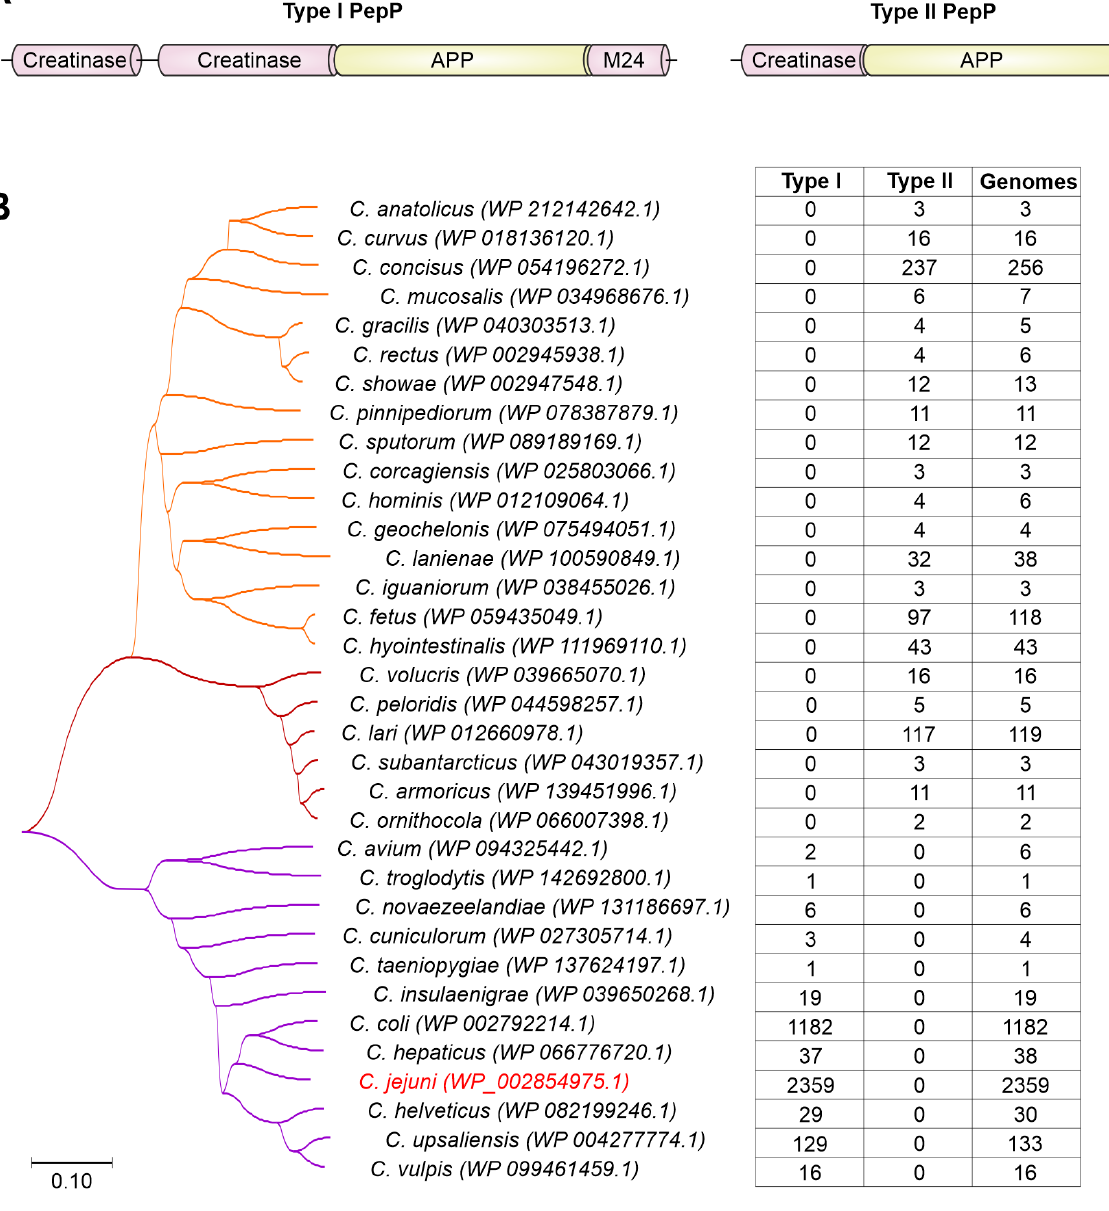
Figure 1. Diversity of proline aminopeptidases found in Campylobacter spp. ( A ) Proposed schematic domain organization of two PepP proteases indicated as Type I and Type II. One or two N-terminal Creatinase domains are followed by C-terminal X-Prolyl Aminopeptidase (APP) domain. Type I PepP additionally has a short M24 peptidase domain at the C-terminus. ( B ) Phylogenetic tree of PepP proteases found in Campylobacter spp. Type I and Type II PepP proteases are indicated by purple and brown/orange branches, respectively. Values in the table correspond to the number of genomes possessing either type I or type II PepP peptidases as identified by tblastn searches against the NCBI RefSeq Genome Database, and the total number of genomes per species in the database. All species have either type I PepP or type II PepP, but not both. In most species, all genomes possess the pepP gene.